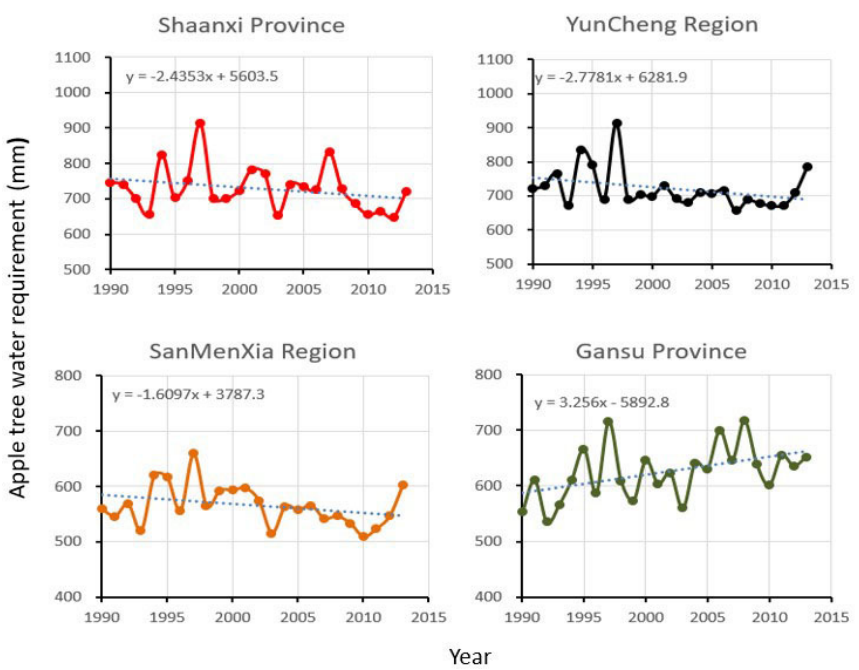
Figure 3. Temporal evolution of water demand of apple trees in each province from 1990 to